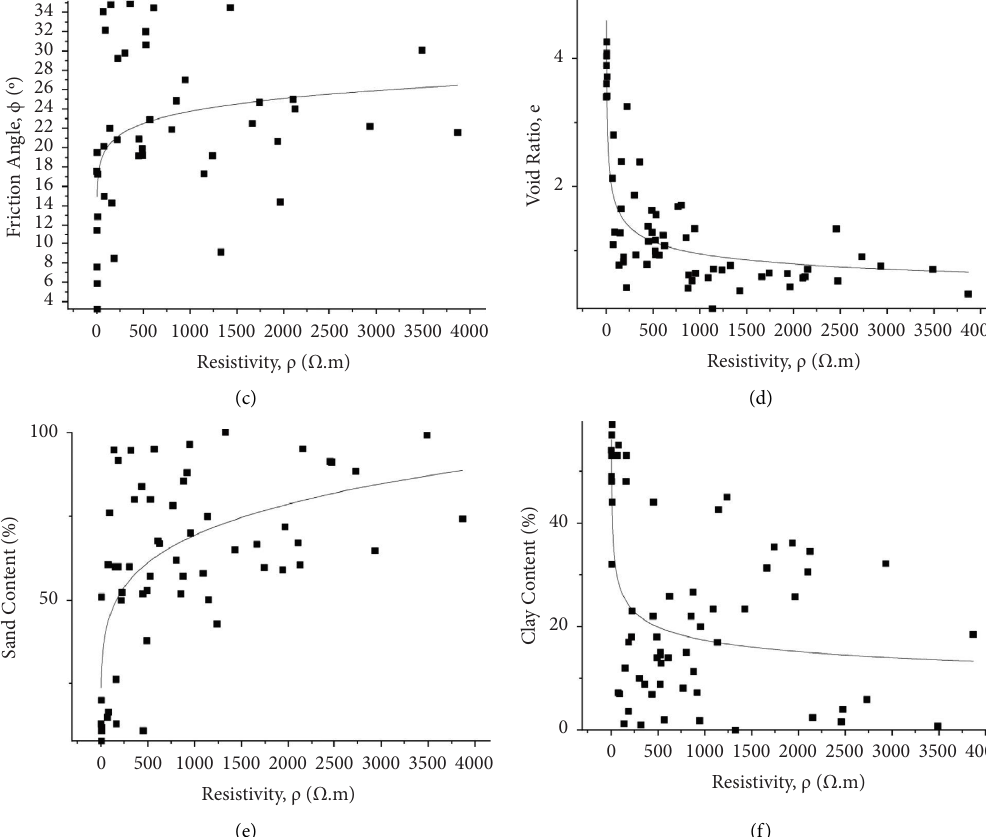
Figure 4: Correlation resistivity in equation y � ax b . (a) Against moisture content; (b) against clay content; (c) against plasticity index; (d) against friction angle; (e) against bulk density; (f) against